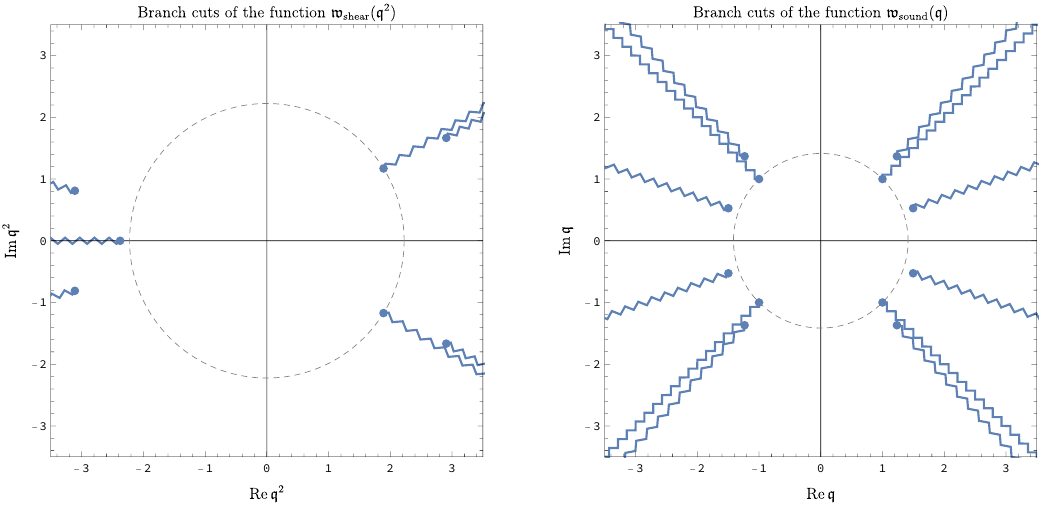
Figure 14 . Branch point singularities, branch cuts and the domain of hydrodynamic series conver- gence for the shear mode in the complex q 2 -plane (left panel) and the sound mode in the complex q -plane (right